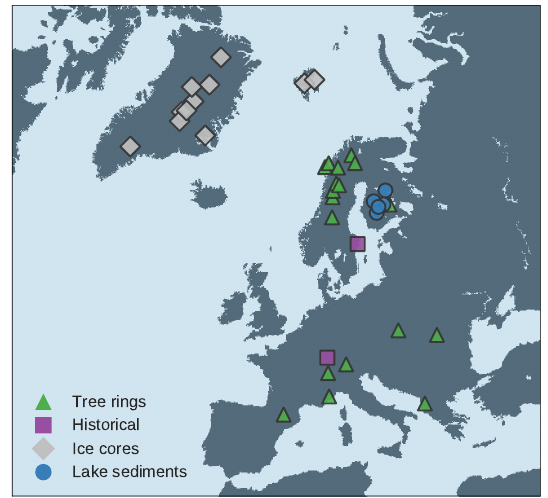
Figure 1. Locations and types of the paleoclimate archives used in this study. Different markers indicate different paleoclimate archives. Detailed information on the individual data sets can be found in Tables S1 and